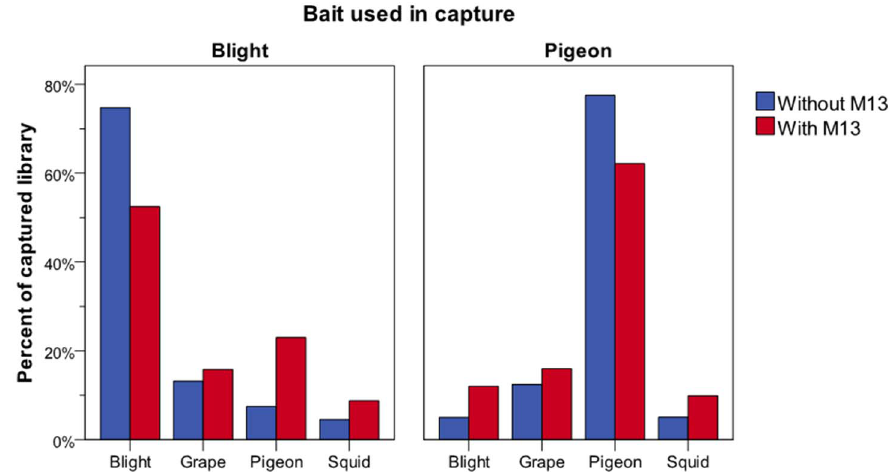
Figure 3. Testing the effects of homology on CapFlank. Non-homologous amplicon libraries with or without M13 adaptors added (Figure S1) representing a potato blight PiRXLRc, giant squid mtDNA ND4, pigeon mtDNA COI, and grape chlorplast rbcL sequences were captured with blight panel A or pigeon panel B 200 bp baits. The capture libraries were then analysed by qPCR for the 250 bp amplicon products for each of the 4 amplicons. Captured libraries without M13 adaptors are shown in blue and with M13 adaptors added shown in red and demonstrate an increase in enrichment with M13 adaptor addition.